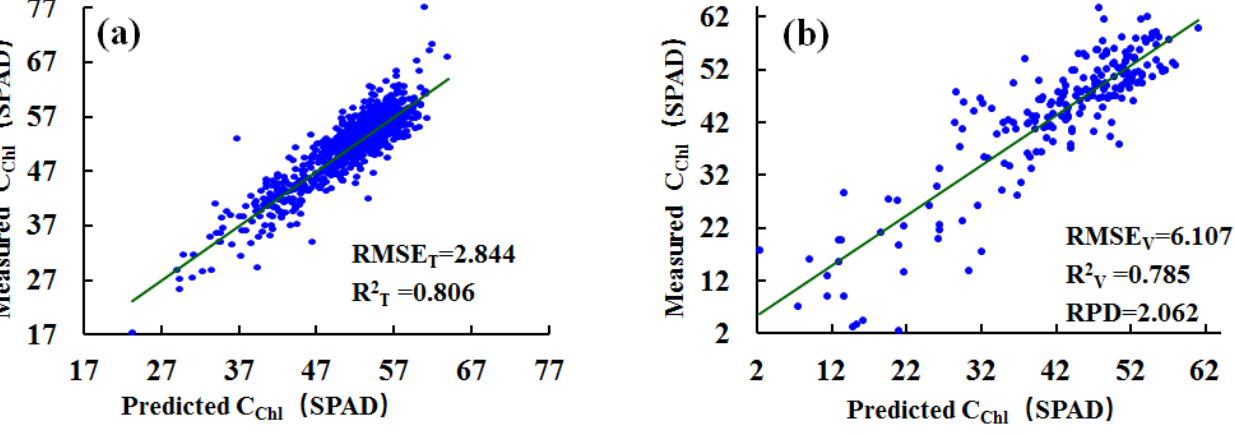
Figure 16. The estimated results of SPAD value for ( a ) training set and ( b ) validation set based on pretreatment WPD-R’-PCADR at whole growth stage.